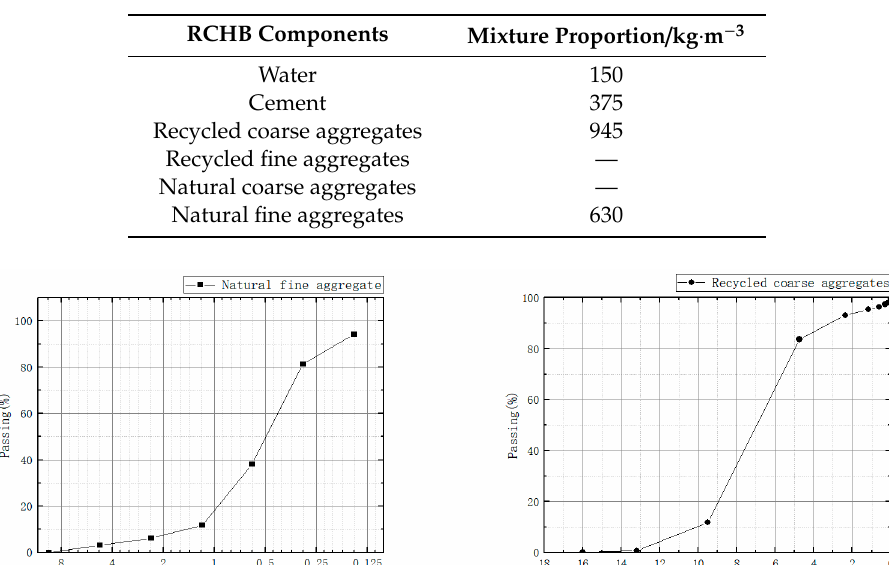
Figure 2. Fuller grading curves.